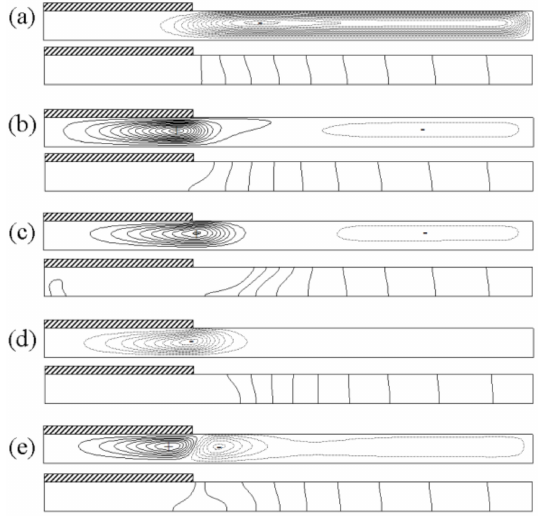
Figure 2. Flow structures (upper) and iso-concentration lines (down) when Re T = 394. ( a ) Re s = 0, Re c = 0, Ψ = 0.012; ( b ) Re = − 561, Re = 0, Ψ = 0.120; ( c ) Re = − 1400, Re = 0, Ψ = 0.80; s c s c max( − ) max( + ) max( + ) ( d ) Re s = 0, Re c = 1871, Ψ max( − ) = 0.015; ( e ) Re s = − 561, Re c = 936, Ψ max( + ) =